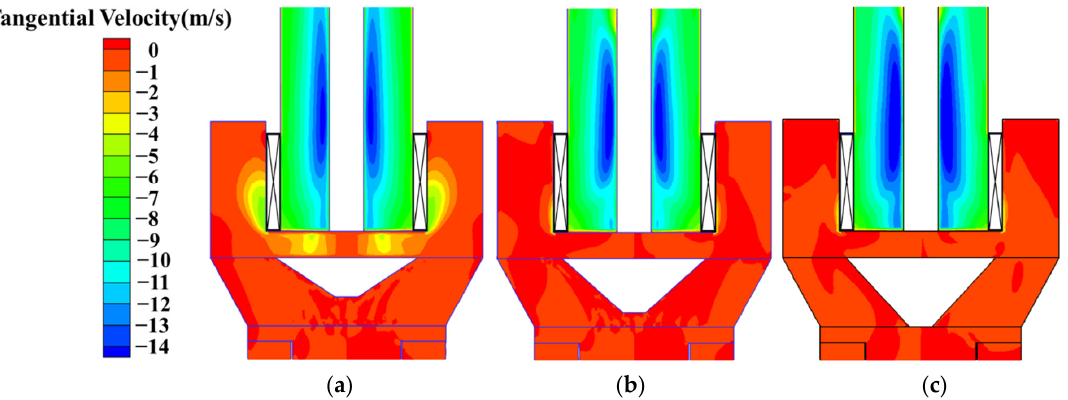
Figure 8. Effect of the guide cone height on the tangential velocity: ( a ) H = 64 mm, ( b ) H = 84 mm, ( c ) H = 104 mm.